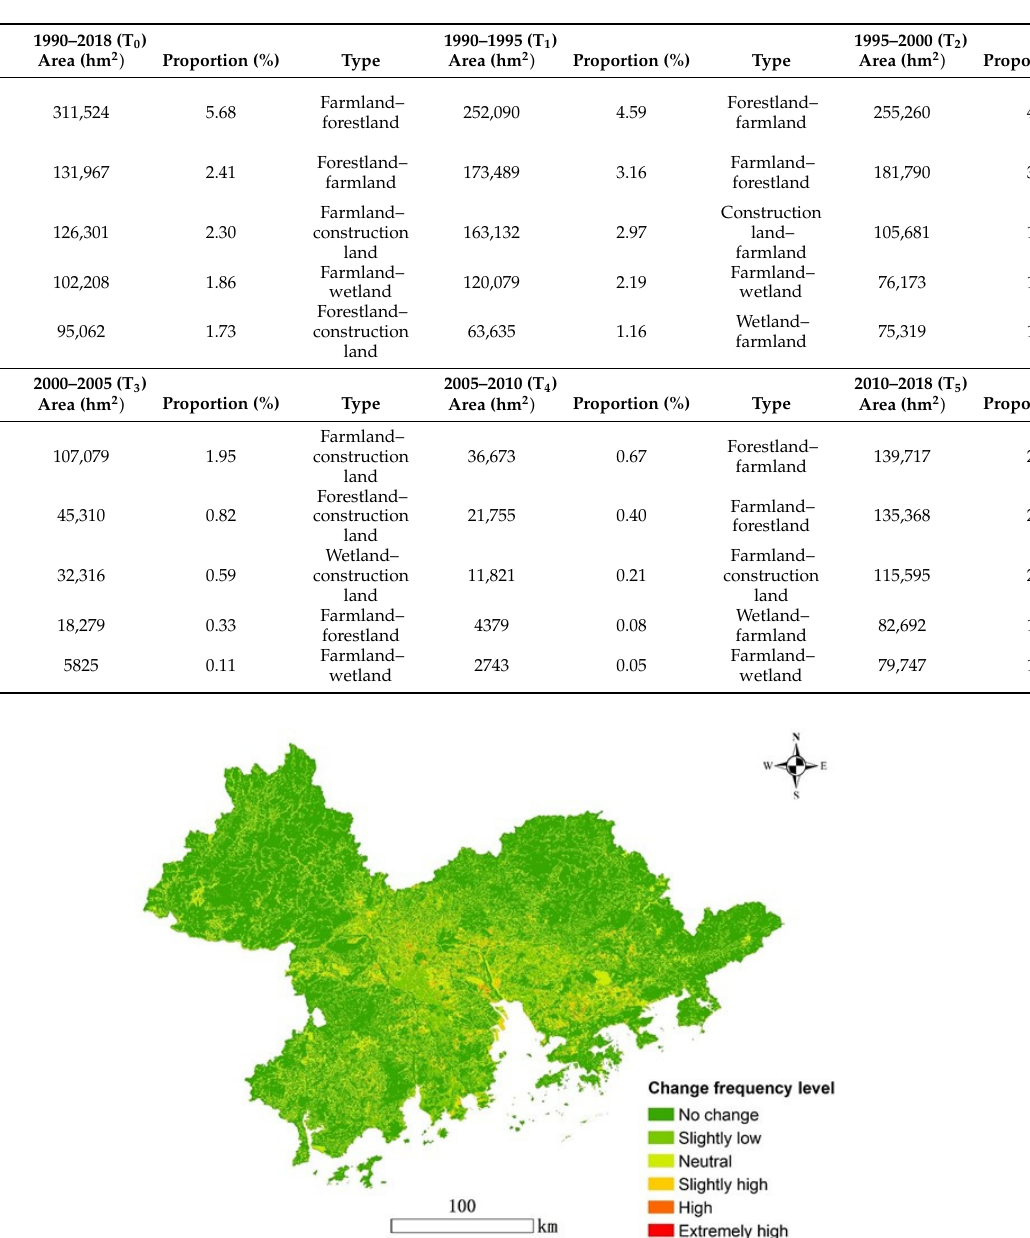
Table 3. The top-five types of land-use change in the GBA in each period. The change in farmland was the main line of change in each period. The conversion of farmland into construction land occupied the first place in both T 3 and T 4 , while it gradually tended to slow down in T 5 .